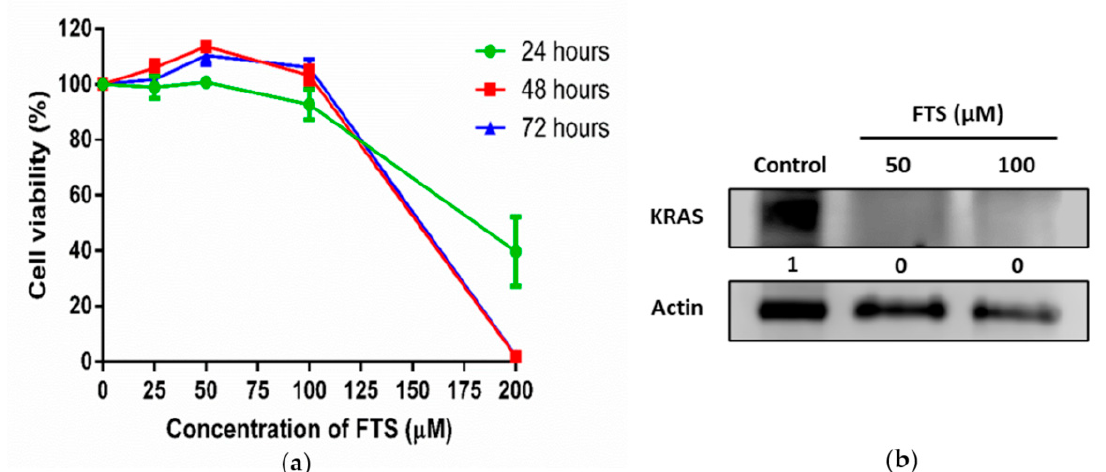
Figure 2. Effect of FTS treatment on cell viability and KRAS expression of SW480 cells. ( a ) Cell viability (%) of SW480 cells treated with various doses of FTS for 24, 48 and 72 h ( n = 3); ( b ) Western blot analysis of KRAS expression in FTS-treated SW480 cells. Actin was used as loading control ( n = 3).